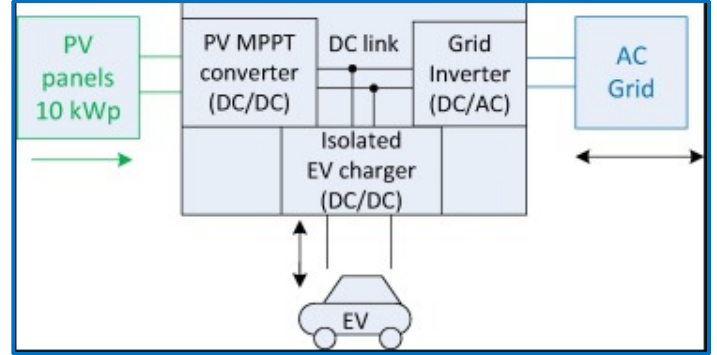
Figure 1. Basic structure of EV charging